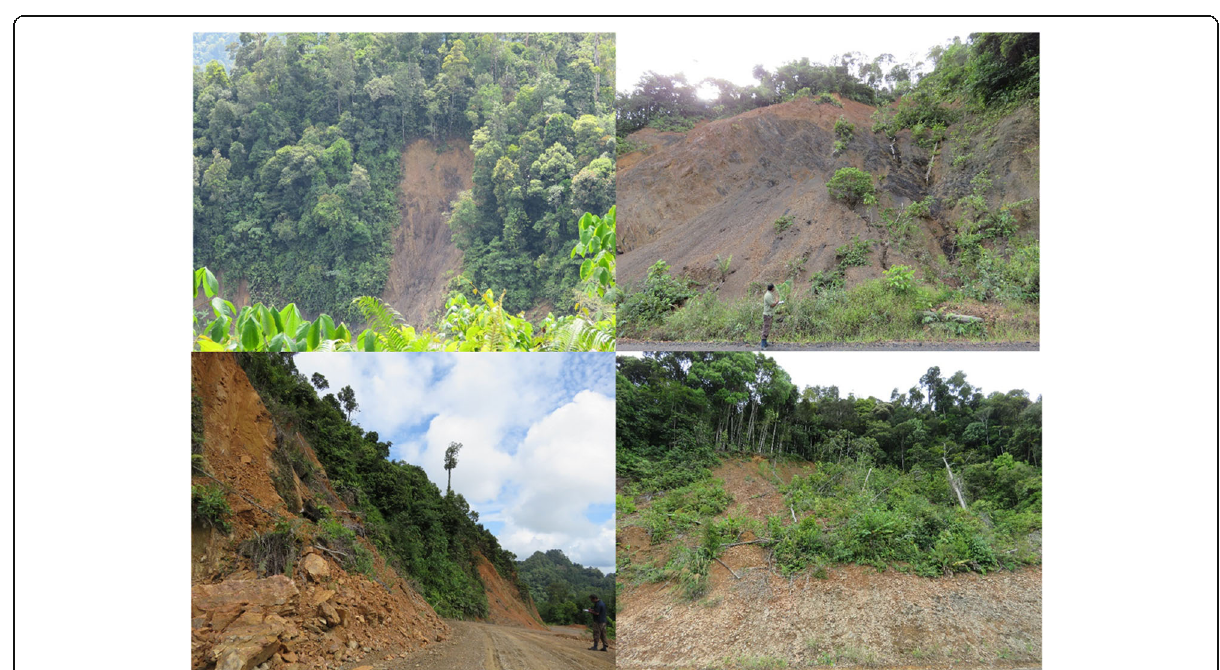
Fig. 1 Slope failures observed in the study